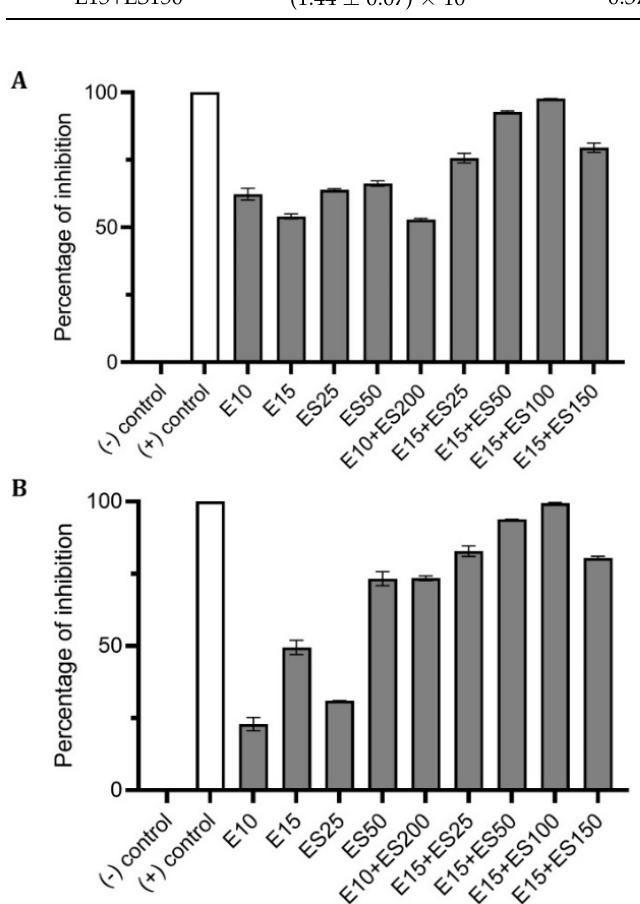
Figure 5. Effect of single and combinatorial treatments of erythromycin (E) and EGCG-S (ES) on biofilm formation in P. aeruginosa . The percentage of inhibition for ( A ) crystal violet assay and ( B ) Resazurin assay were calculated from respective measurement. (-) control: PBS buffer; (+) control: 10% bleach. Experiments were repeated in triplicates. Means are shown with SD. The percentage of inhibition with different concentrations of erythromycin and EGCG-S indicated that E10+ES100 concentration effectively inhibits biofilm formation of P. aeruginosa .